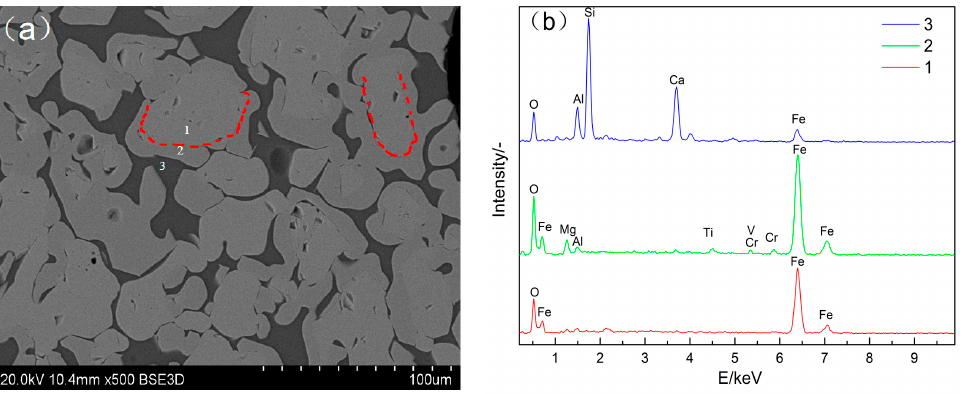
Figure 7. SEM-EDS images of an acid (R = 0.50) PVTM sinter. ( a ) SEM Image; ( b ) EDS image.